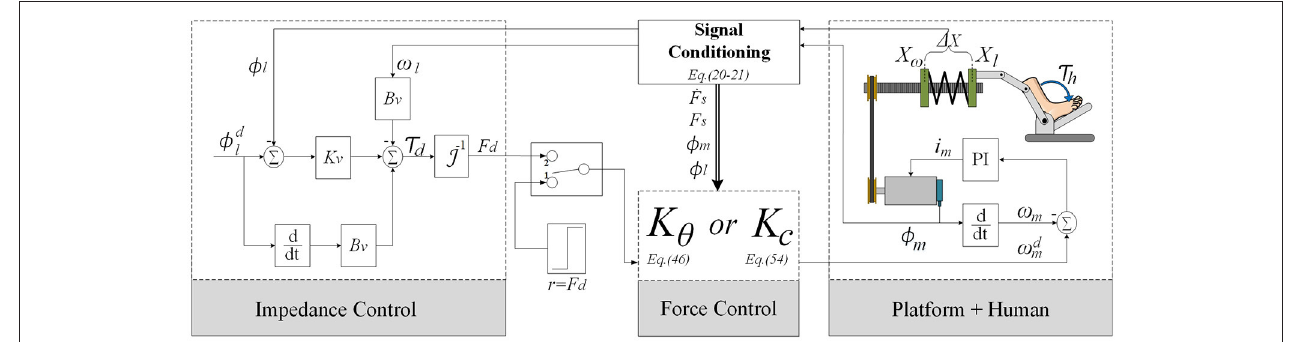
FIGURE 3 | Overall control scheme for the